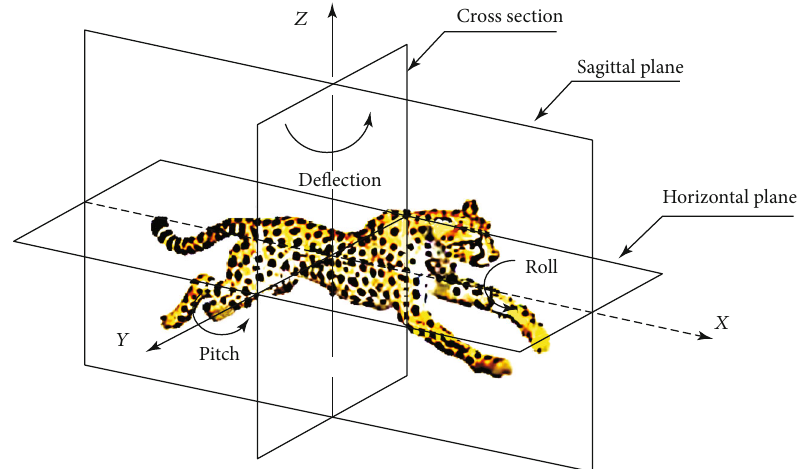
Figure 3: Spine skeleton diagram of cheetah.